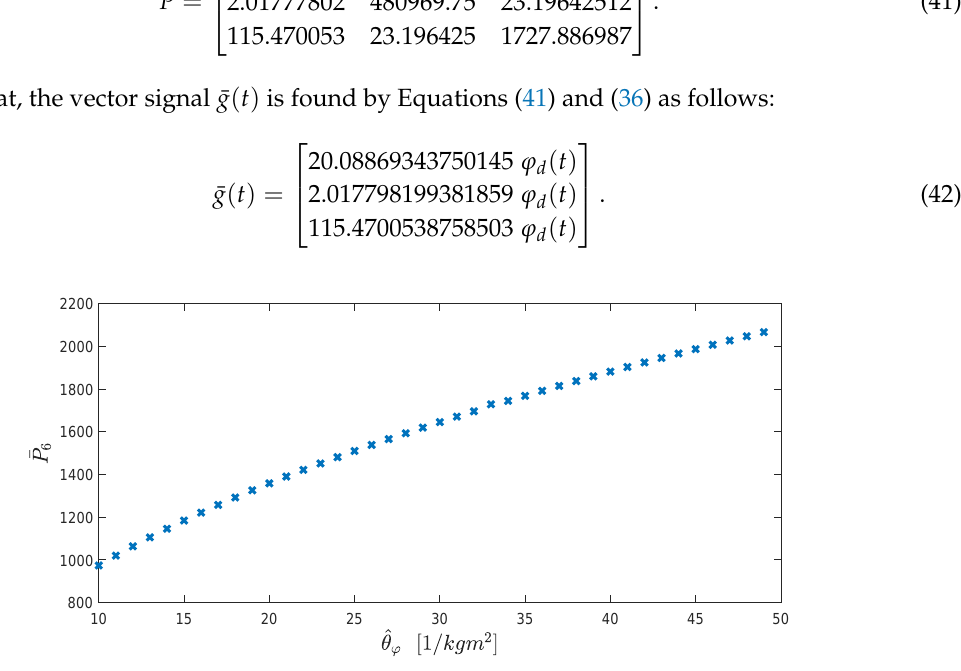
Figure 5. Offline calculation of ¯ P 6 for the estimate ˆ θ ϕ ∈ [ θ ϕ , θ ϕ ]